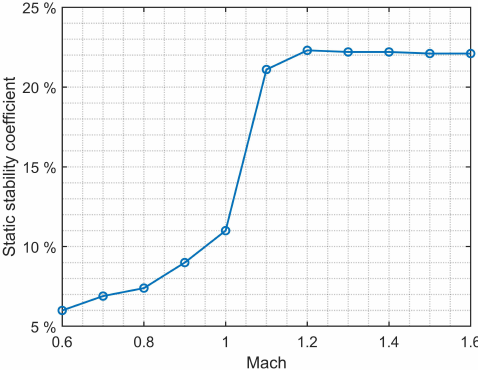
Figure 4. Longitudinal static stability along the flight